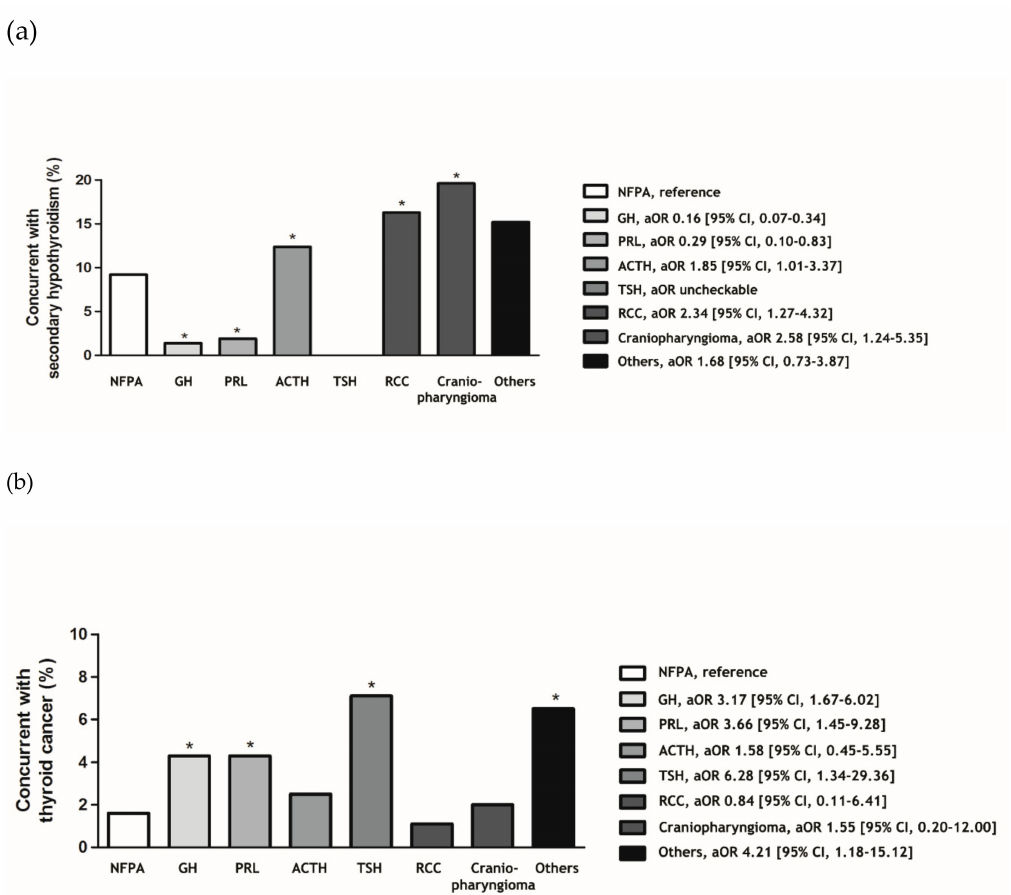
Figure 2. The concurrence rate and odds ratios of central hypothyroidism and thyroid cancer according to type of pituitary disease. Multiple logistic regression analysis was performed to evaluate the concurrent risk of ( a ) central hypothyroidism and ( b ) thyroid cancer. The multiple logistic regression model was adjusted for age and sex. Abbreviations: NFPA: nonfunctioning pituitary adenoma; GH: growth hormone-secreting pituitary adenoma (including GH and PRL co-secreting pituitary adenoma); PRL: prolactin-secreting pituitary adenoma; ACTH: adrenocorticotropic hormone-secreting pituitary adenoma; TSH: thyroid-stimulating hormone-secreting pituitary adenoma (including GH and TSH co-secreting pituitary adenoma); RCC: Rathke’s cleft cyst. * p -values <